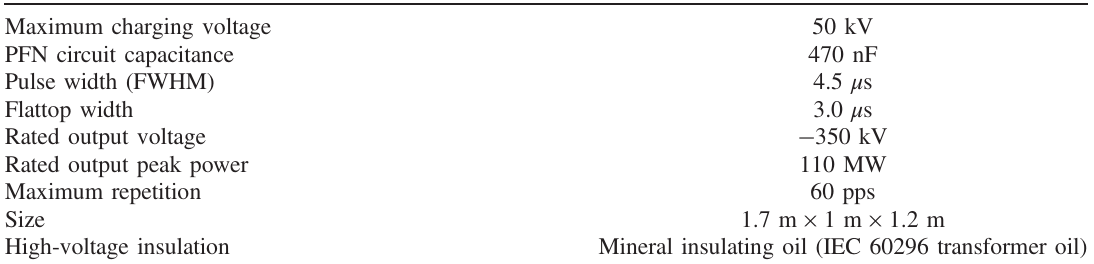
TABLE III. Specifications of the klystron modulator.